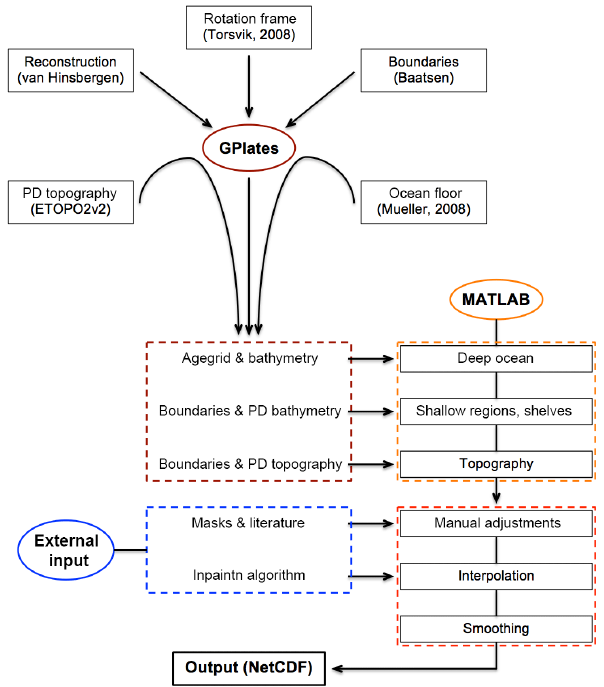
Figure 7. Flowchart of the procedure; the plate-tectonic reconstruc- tion is made with GPlates, using a set of reconstructed plate trajec- tories (Seton et al., 2012; van Hinsbergen et al., 2015), a reference rotational frame (Torsvik et al., 2008) and a set of boundary masks delimiting present-day coastlines, continental shelf breaks, shallow ocean regions and some regions that need manual adjustments (see Figs. 1 and 4). In addition to the reconstruction, present-day (PD) topography and bathymetry base files are manipulated using the same rotational frame and adjusted to the configuration at the aimed time frame. The resulting output files as well as some external input are then fed into a MATLAB script which builds up a global ge- ography dataset through several consecutive steps and stores it as a NetCDF